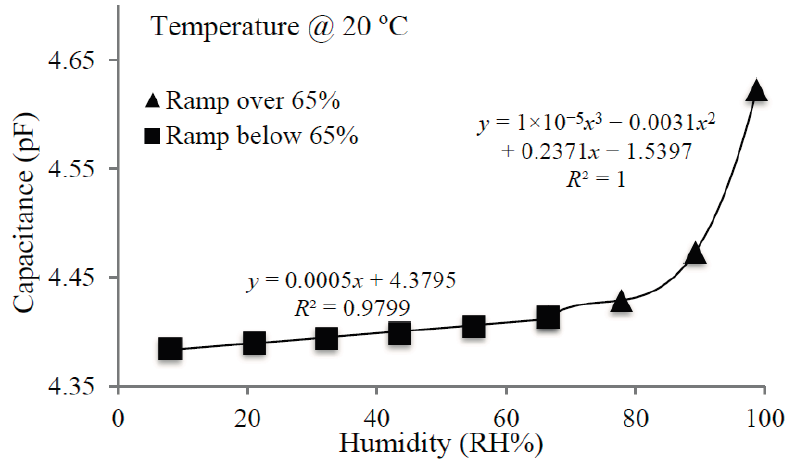
Figure 9. Capacitance vs. humidity plot using Cu(bdc)·xH 2 O